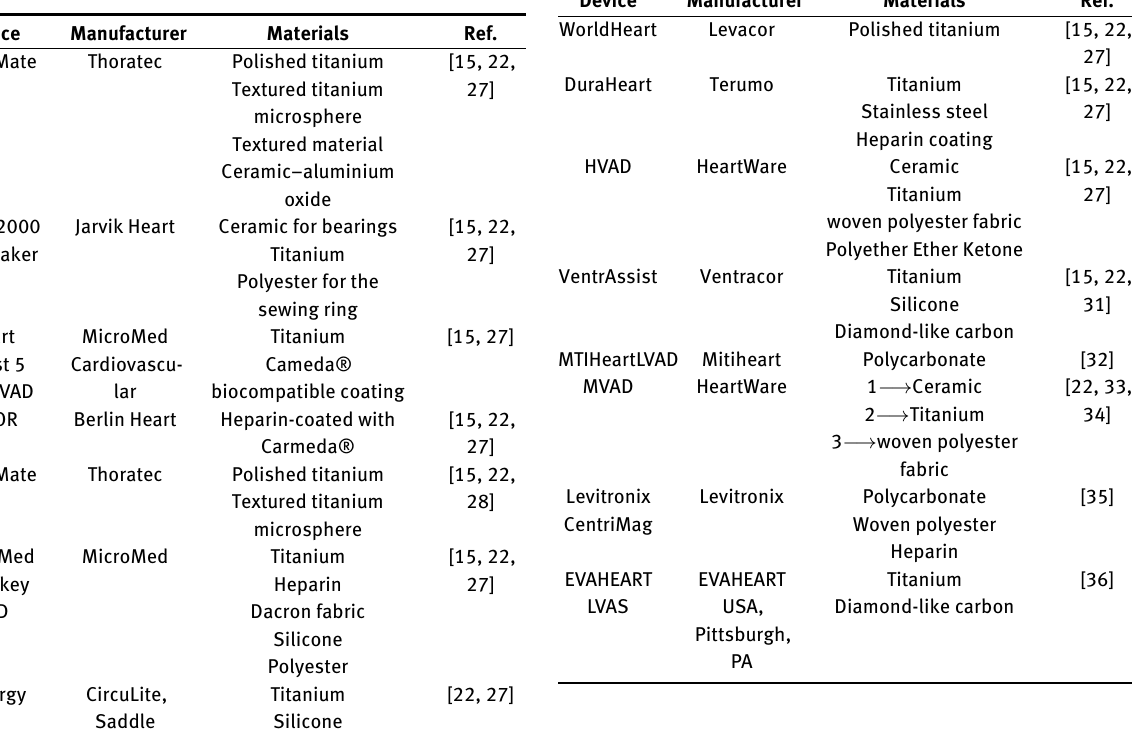
Table 3: The clinical implantable of centrifugal heart